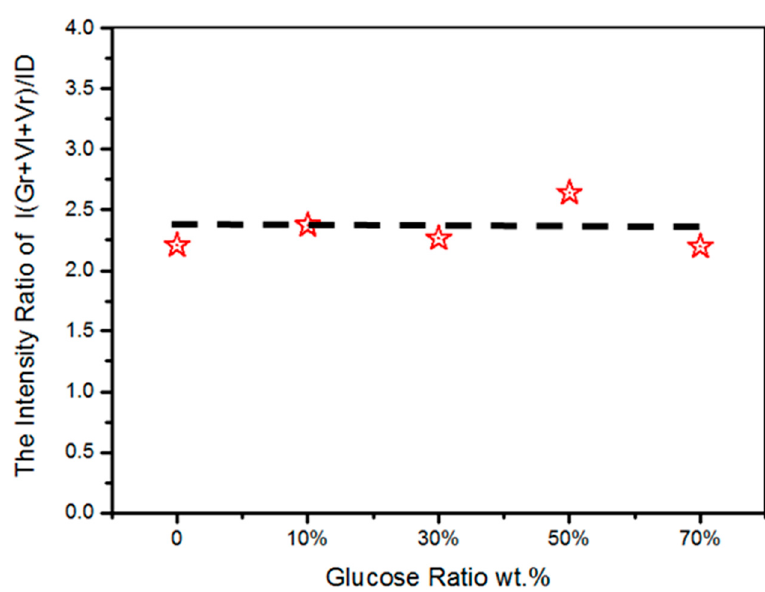
Figure 7. The changes in the ratio of small to large aromatic ring systems in chars as a function of glucose percentage in the feedstock.